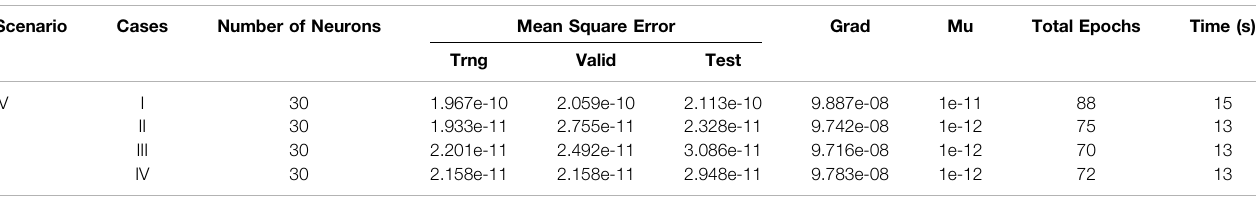
TABLE 7 | Numerical performance indicators for scenario